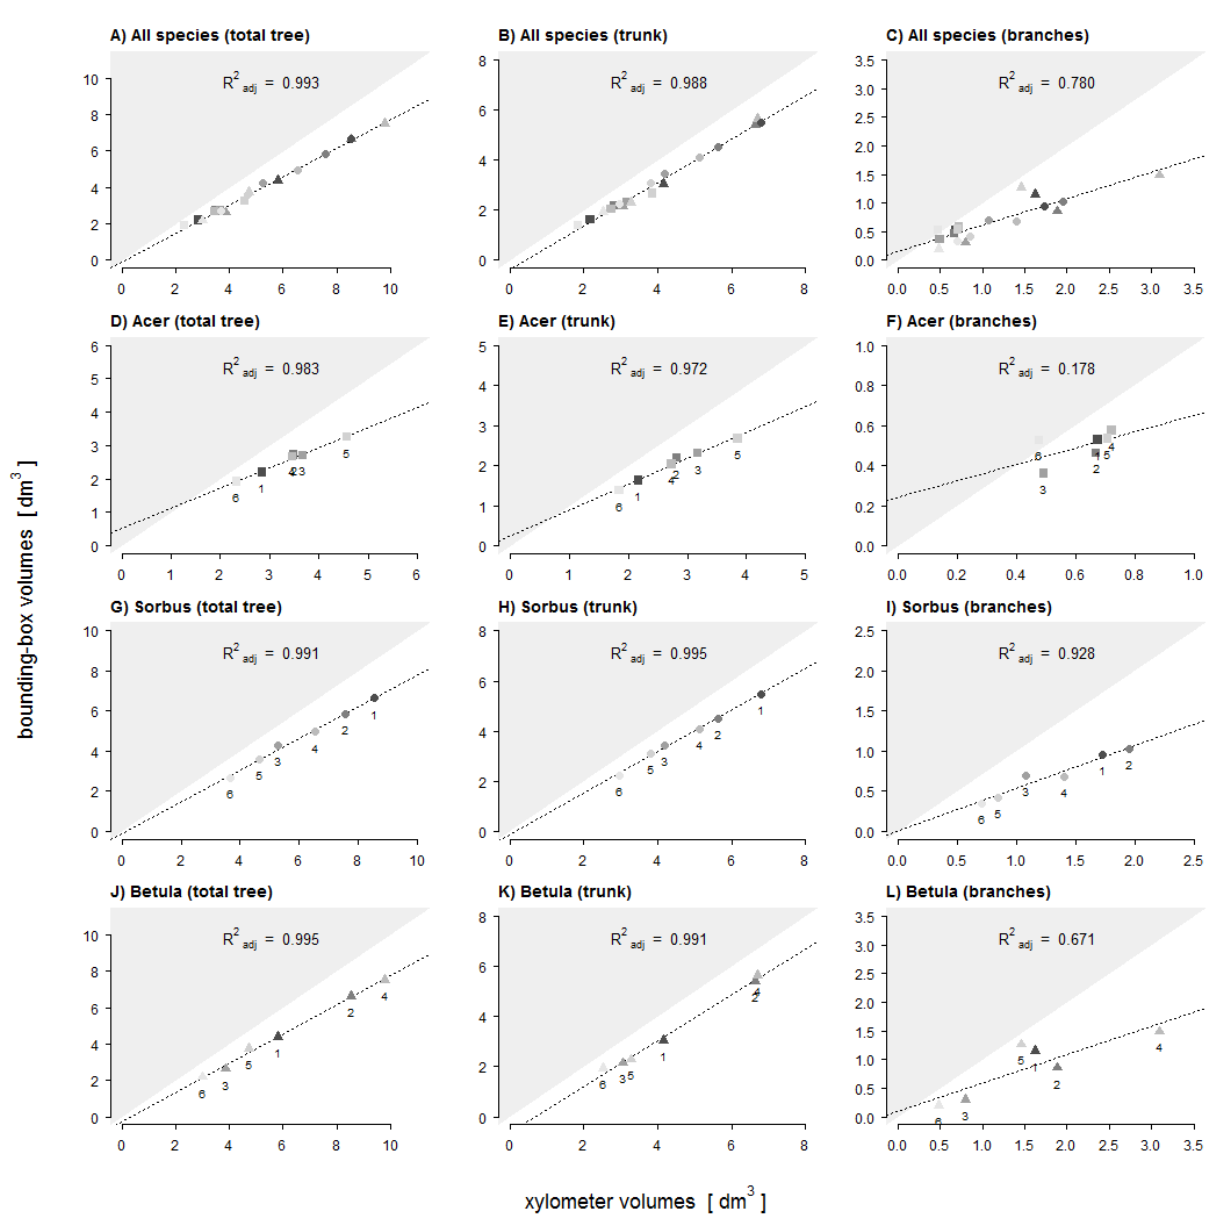
Figure 7. Regression plots of xylometric and bounding box volumes with determined R 2 adj values for the total tree, trunk and branches of all trees ( A – C ), Acer ( D – F ), Sorbus ( G – I ) and Betula ( J – L ). 1:1 line is visualized by the borderline of the grey